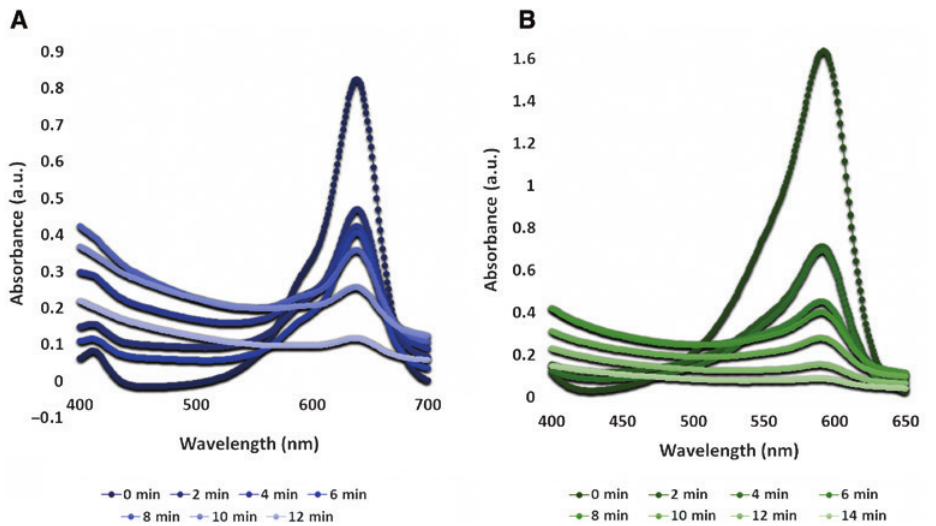
Figure 6: Photocatalytic role of foliar doped nanoparticles and alleviating UV-Vis spectra with time: (A) bromocresol green and (B) bromophenol